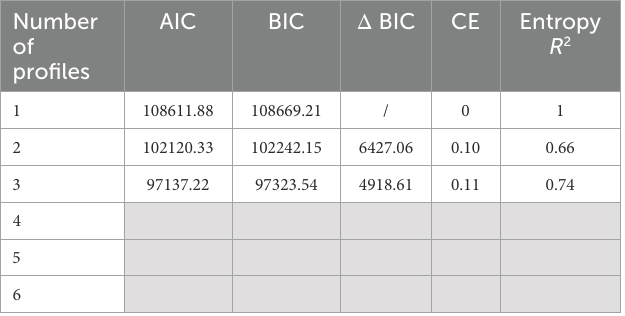
TABLE 1 Model fit statistics for the latent profile analysis for sample A (Fall). Number of profiles